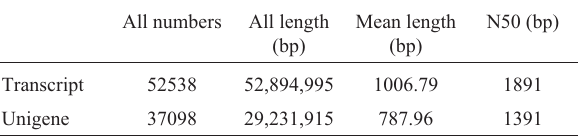
Table 2 - Statistics of assembled